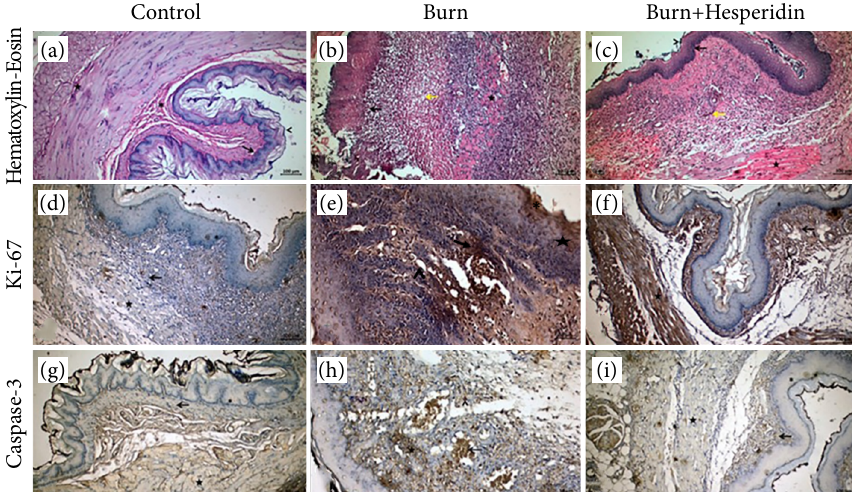
Figure 1 – Demonstration of H&E (a–c) , Ki-67 (d–f) , and caspase-3 (g–i) findings in all groups. (a) Intense keratinized epithelium (arrowhead) and the basement regular membrane with normal the connective tissue cells (asterisk) and the blood vessels (star); (b) Degenerations and nuclei loss (arrowhead), increased apoptosis in the basement membrane (black arrow) and intense leukocyte infiltration (yellow star), vascular dilatation and congestion (asterisk), and degeneration in the muscle layer (star); (c) Regular epithelium was regular (arrowhead) with regular basement membrane (black arrow), and decreased leukocytes (yellow arrow); (d) Negative ki- 67 expression in the epithelial layer (asterisk), lamina propria (arrow), and muscularis mucosa (star); (e) Intense ki-67 expression in germinative cells (asterisk), inflammatory cells (arrow), endothelial cells (arrowhead), and lamina propria (star); (f) Positive ki-67 expression in the epithelial layer (asterisk), some inflammatory cells (arrow), vascular structures (arrowhead), and muscle bundles (star); (g) Negative caspase-3 expression in the esophageal epithelium (asterisk), lamina propria (arrow), and muscle layer (star); (h) Intense caspase-3 expression in the lamina propria (star), inflammatory cells (arrow), and connective tissue cells (arrowhead); (i) Negative caspase-3 expression in the epithelial layer (asterisk), lamina propria (arrow), and muscle layer (star). Scale bar: 100 μ m, Magnification: